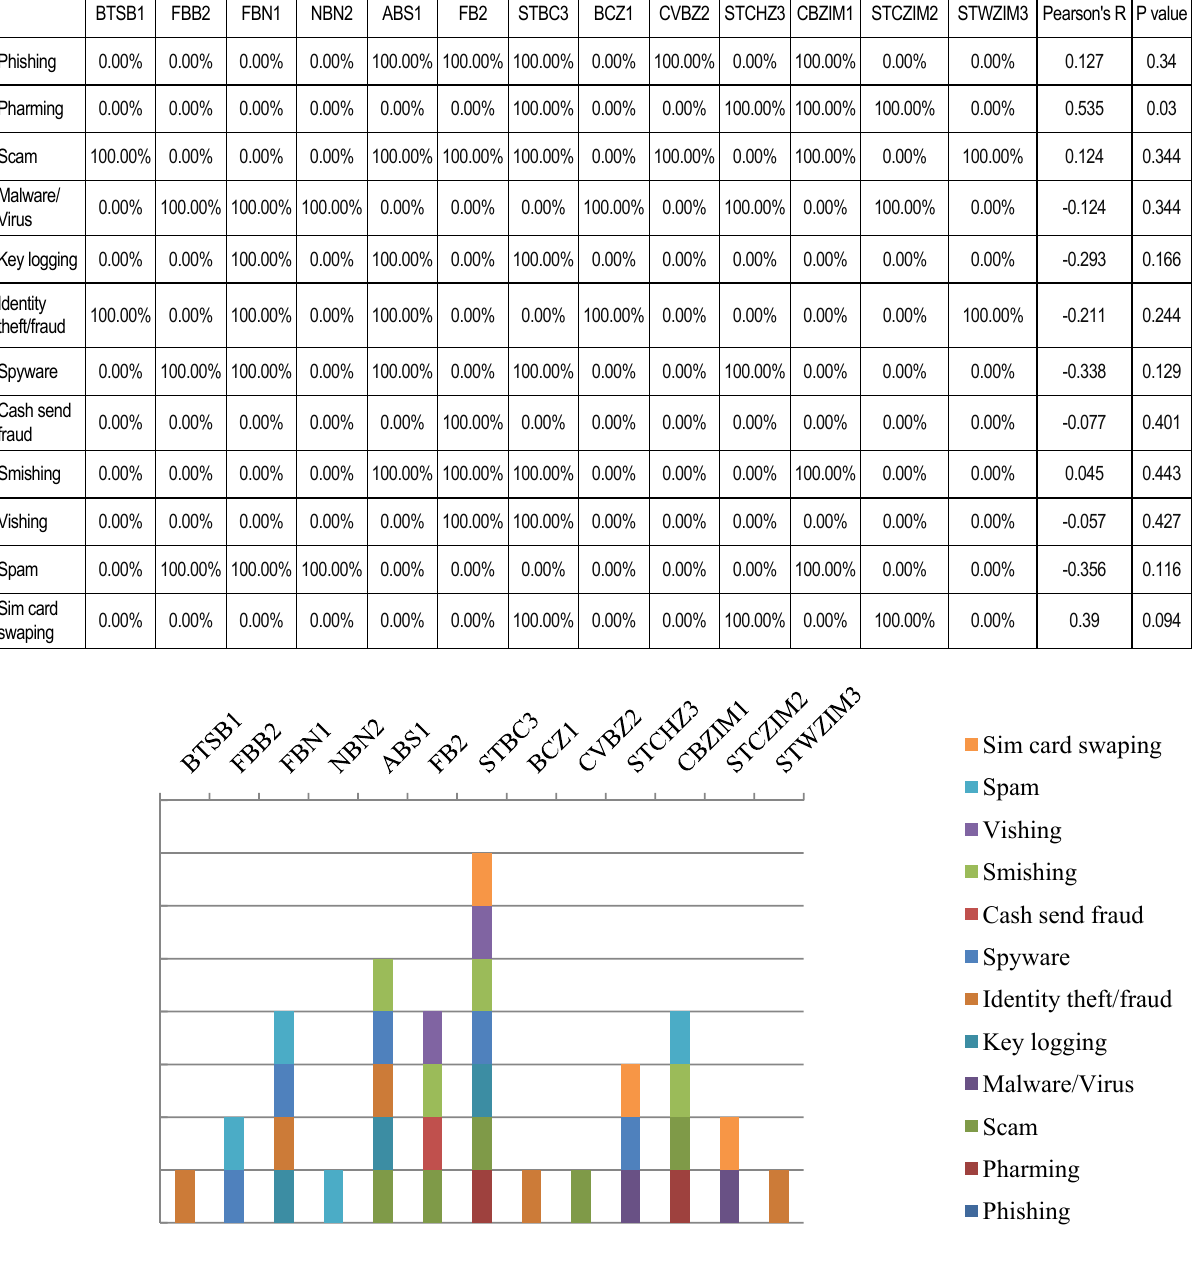
Fig. 2. Internet banking fraud awareness – bar